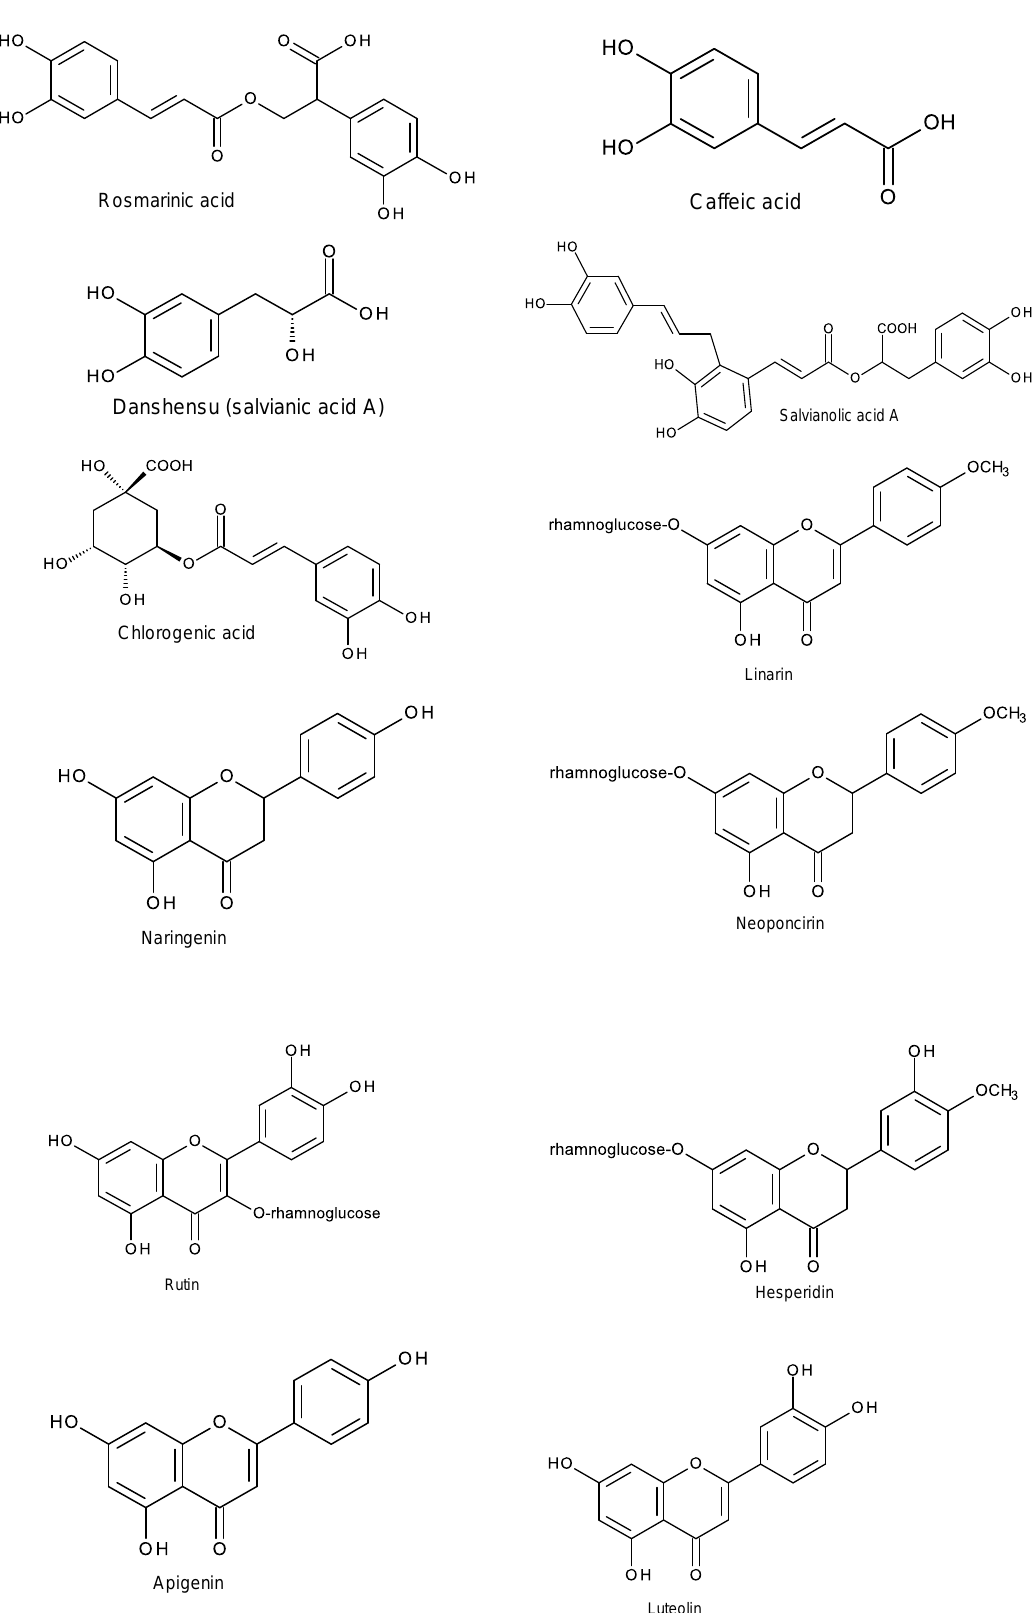
Figure 5. Chemical structure of some phenolic compounds with reported bioactivities relevant to AD identified in the Mentha